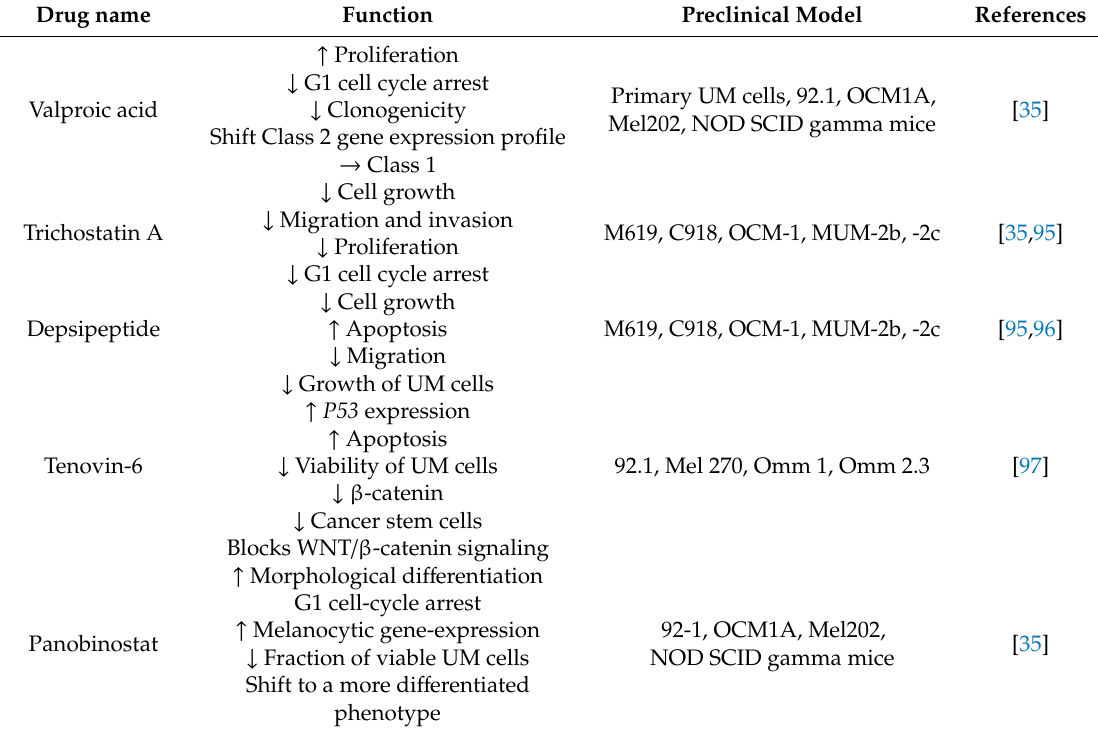
Table 1. Preclinical studies focused on epigenetic drug anti-cancer e ff ects in uveal melanoma. Drug